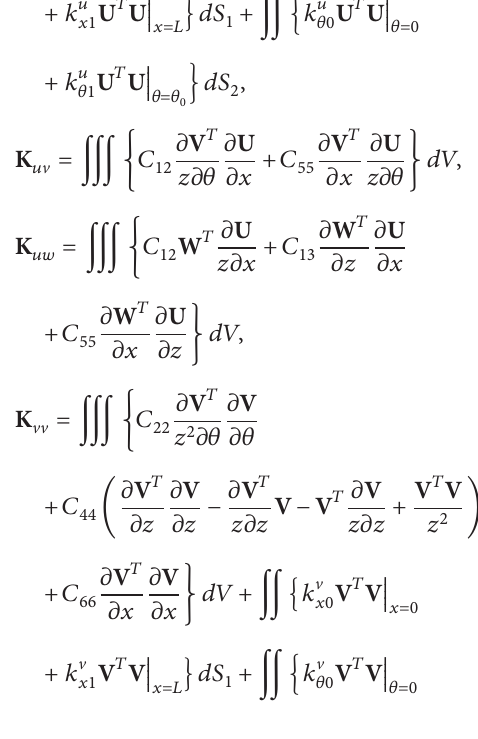
Figure 7: Mode shapes of an isotropic spherical shell with CFCF boundary conditions and various meridional dimensions.